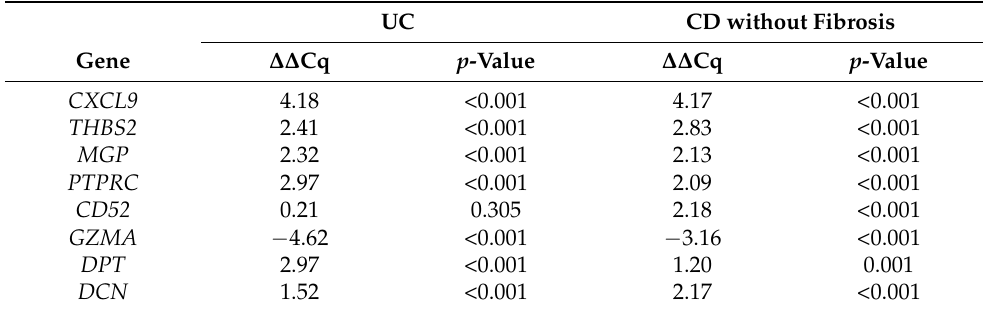
Table 5. Gene expression of CXCL9 , THBS2 , MGP , PTPRC , CD52 , GZMA , DPT and DCN in colonic CD with fibrosis as ∆∆ Cq relative to colonic CD without fibrosis and UC. Legend: CD, Crohn’s disease; UC, ulcerative